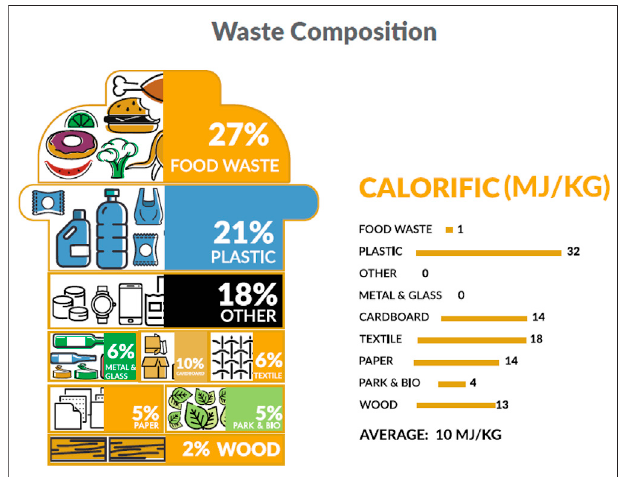
FIGURE 8 | Calori fi c value of waste composition in Oman (Beigl et al.,